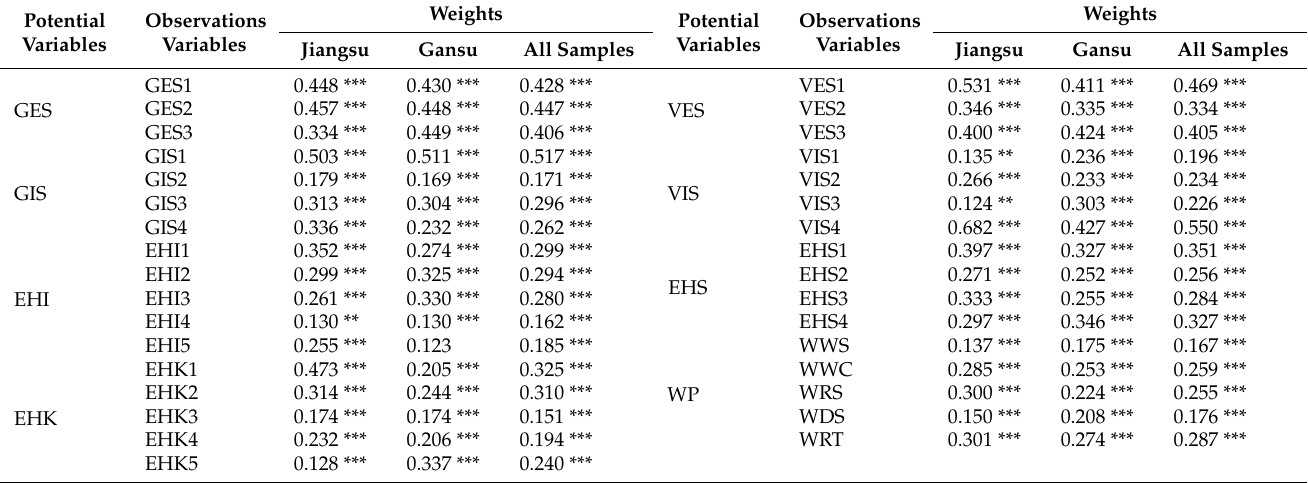
Table 3. Indicator loading results of the measurement